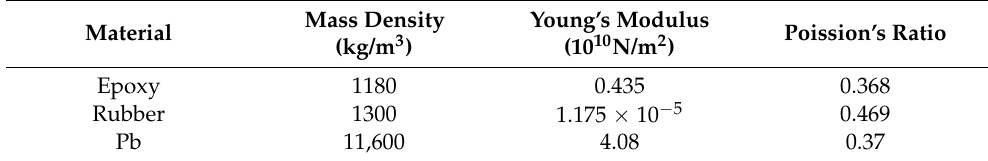
Figure 1. ( a ) The stubbed-on LRPC DPS with resonator unit surrounded by soft shell (soft shell is ignored), and ( b ) its unit cell (upper plate is ignored), a is the lattice constant, e is the thickness of base plates, r is the radius of pillar, R S 1 is the outer radius of added soft shell and R S 2 is the inner radius of added soft shell. Table 1. Materials’ parameters used in calculations in Figure 2.